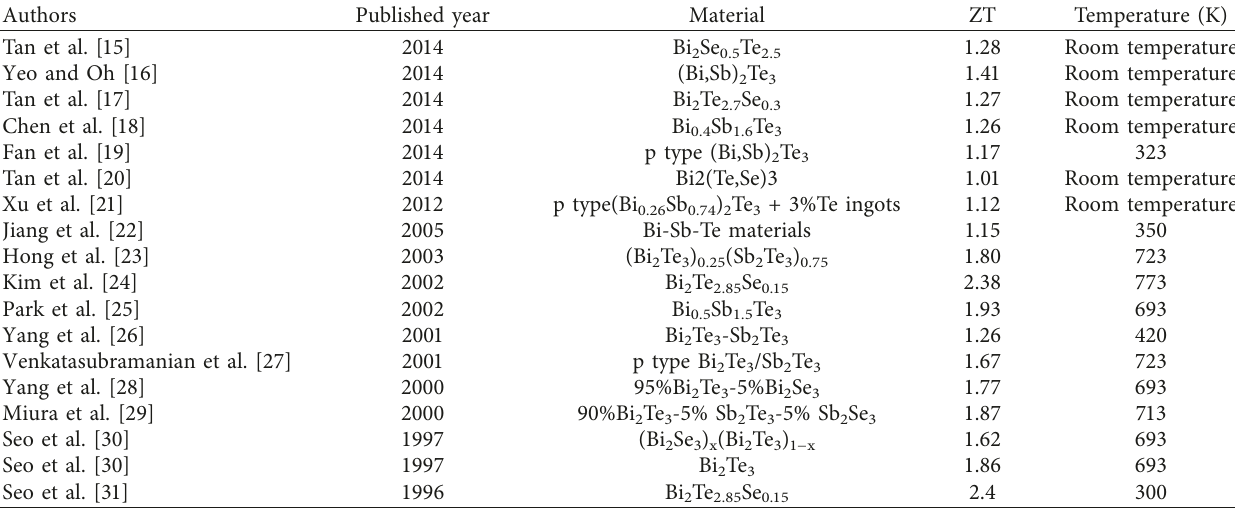
Table 1: The value of ZT of the Bi-Te-based material (reproduced from [13] with permission).